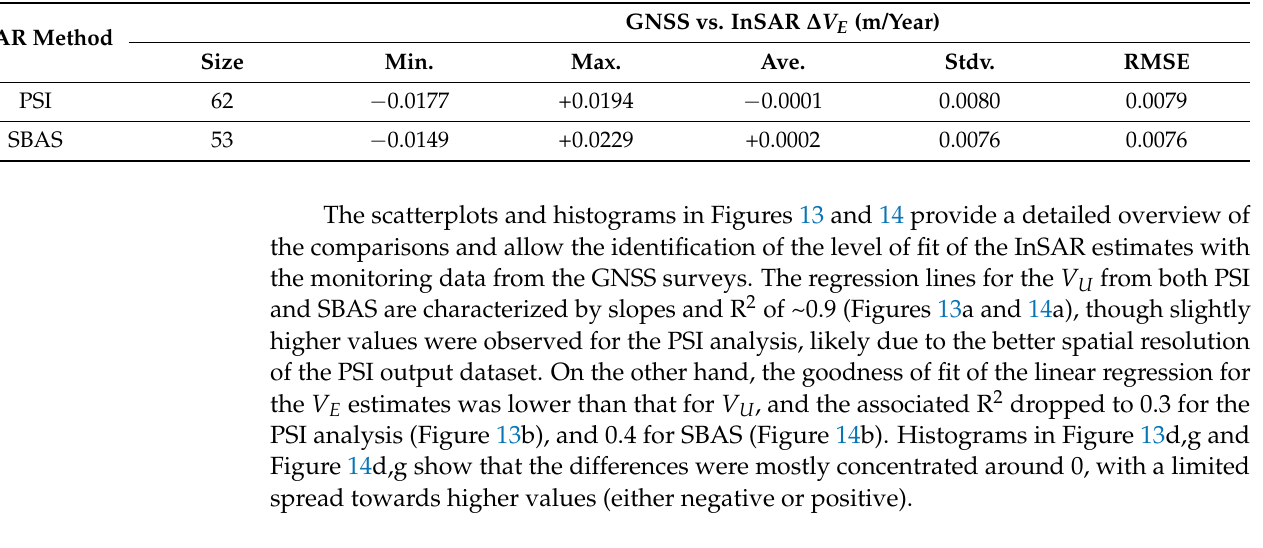
Table 3. Difference in east-west velocity ∆ V E estimated from the PSI and SBAS InSAR analyses with respect to that recorded with GNSS (permanent stations and benchmark surveying). The size indicates the number of benchmarks used for